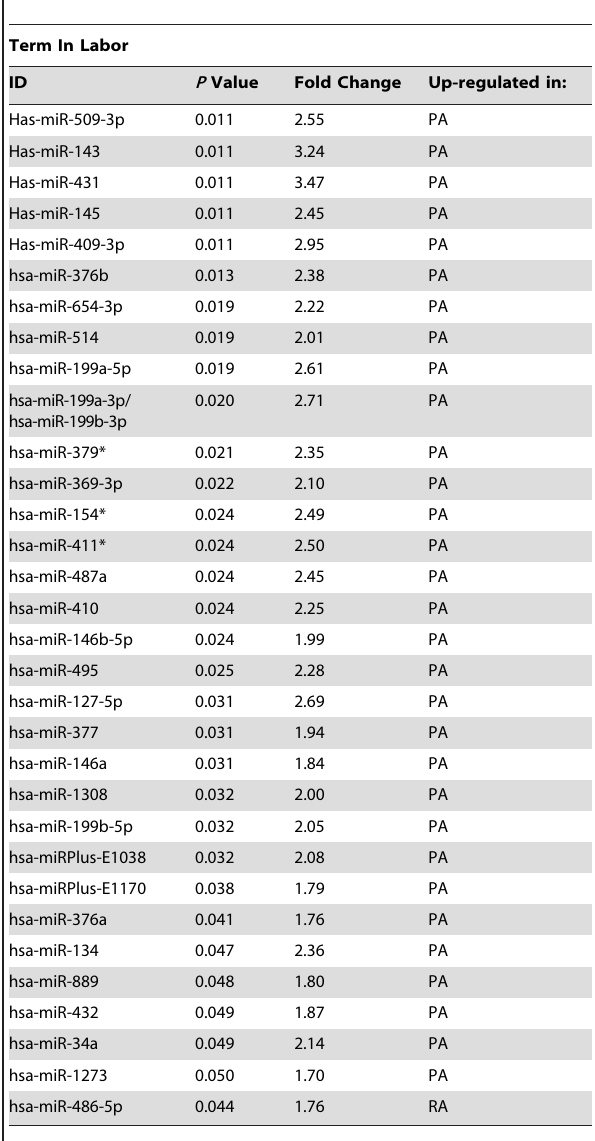
Table 2. Differentially expressed miRNAs between placental amnion (PA) and reflected amnion (RA) with labor.